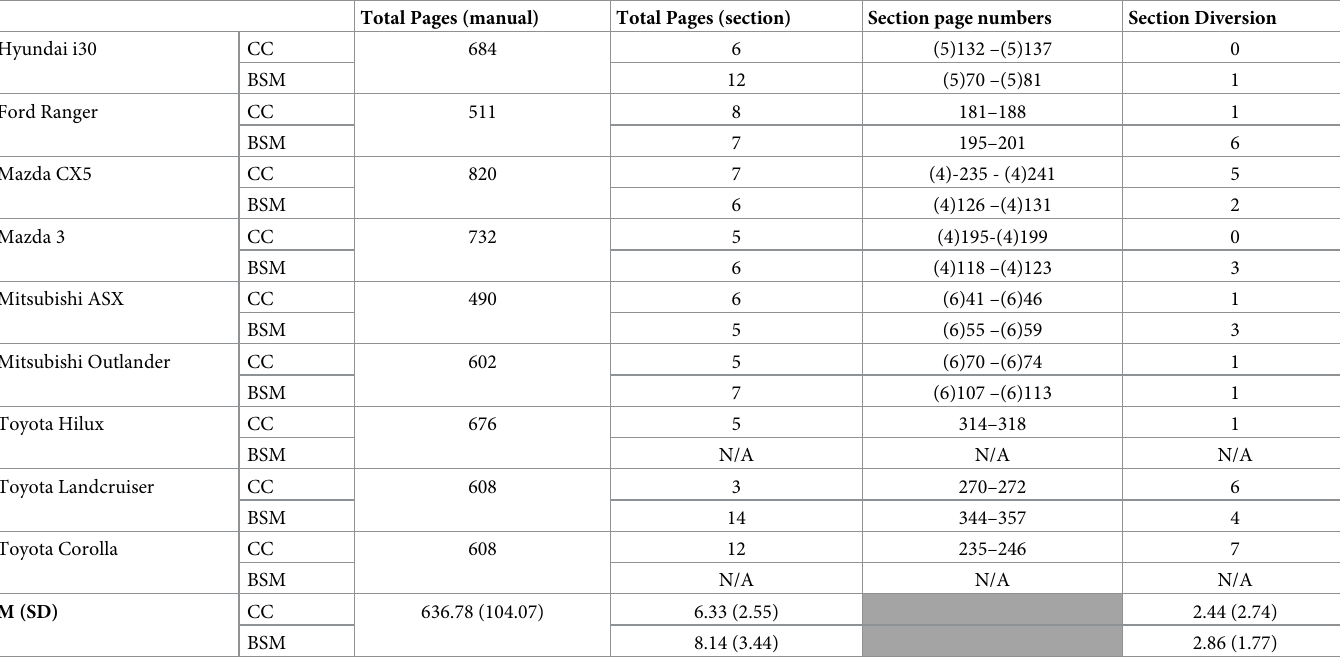
Table 4. Quantitative analysis of section